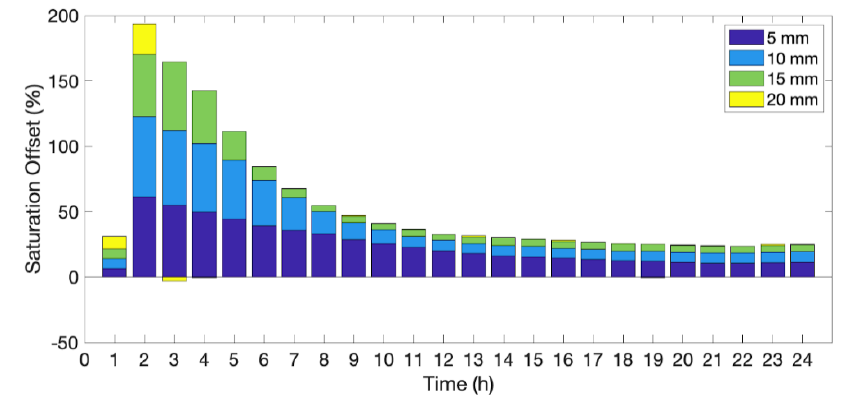
Figure 4. aFO-DTS results using the 15-min calibration for 5, 10, 15, and 20 mm of recharge. Recharge occurs during the second hour of the test. The bar chart is cumulative; for example, at 2 h, the saturation offset for the 20 mm simulation is 39%.